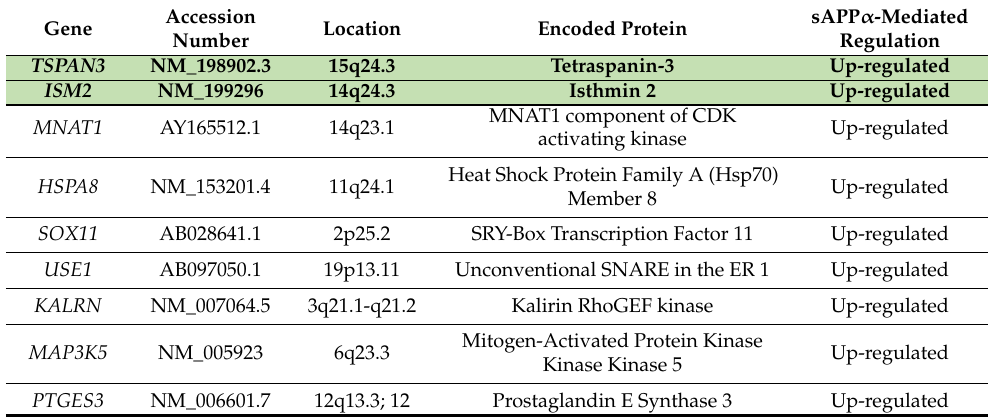
Table 2. In vitro sAPP α -mediated differentially regulated genes obtained from the differential display analysis performed on SH-SY5Y neuroblastoma cells ( green highlight = up-regulated genes of interest; orange highlight = down-regulated genes of